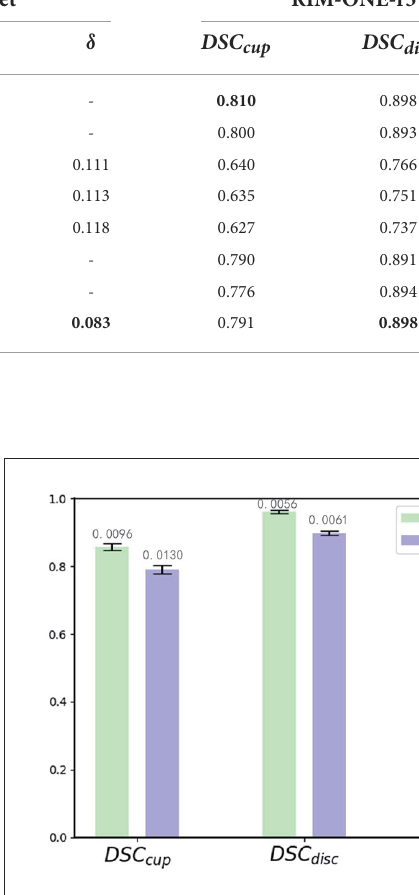
FIGURE3 Mean performance and standard deviation on the Drishti-GS dataset and the RIM-ONE-r3